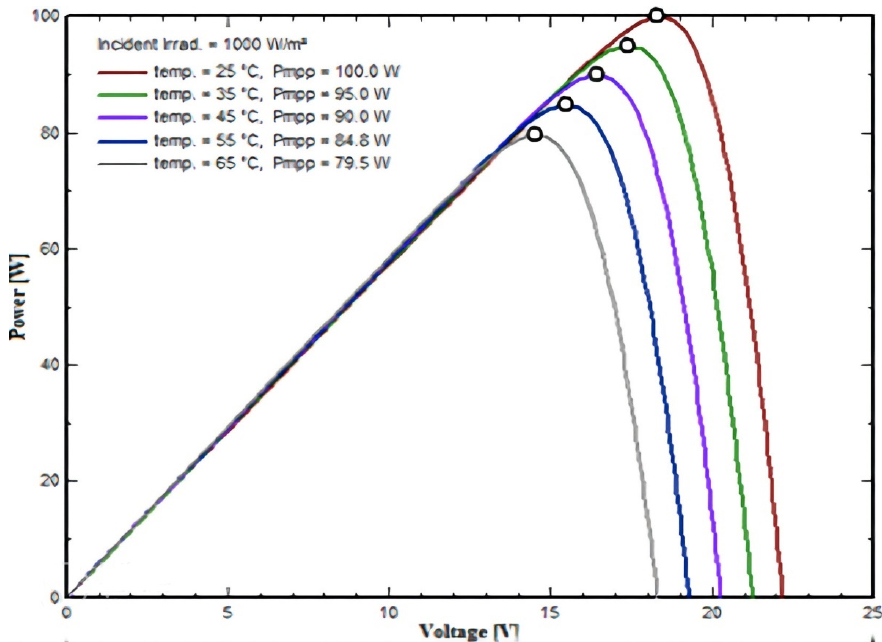
Figure 13. A PV panel’s P-V curve characteristics under a constant solar irradiance of 1000 Wm − 2 at different temperatures [86]. Table 5. Summary of the literature that concerns the effect of temperature on PV